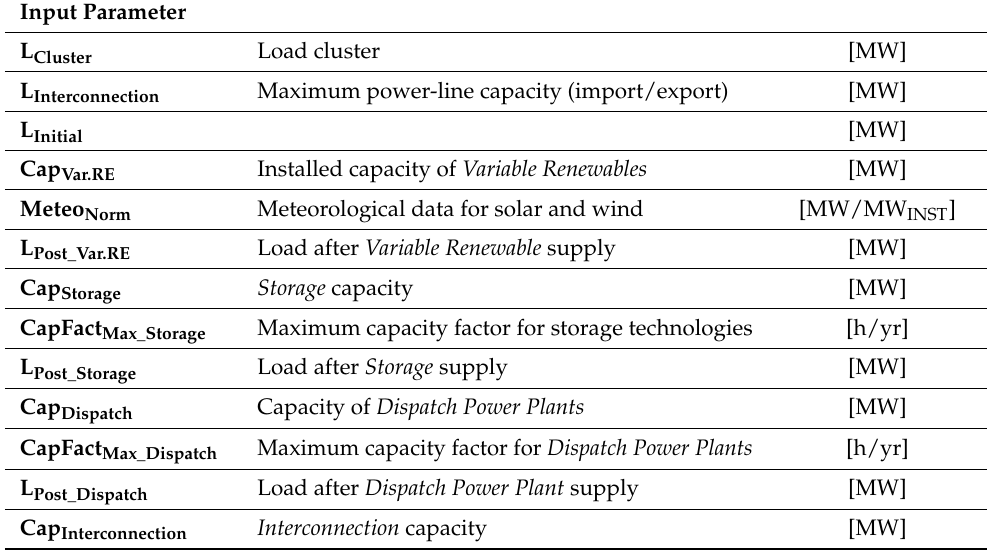
Table 7. Input parameters for the dispatch